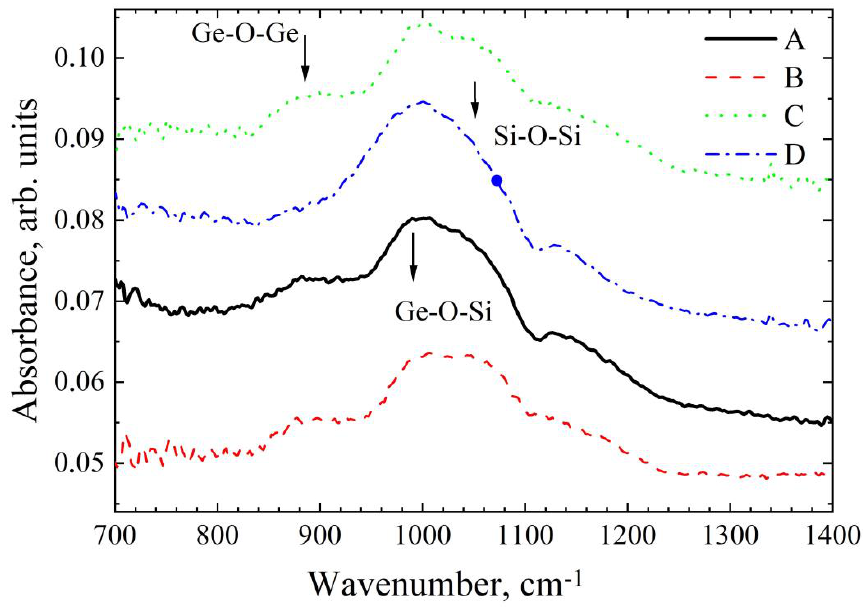
Figure 5. IR absorption spectra for samples A, B, C, and D.